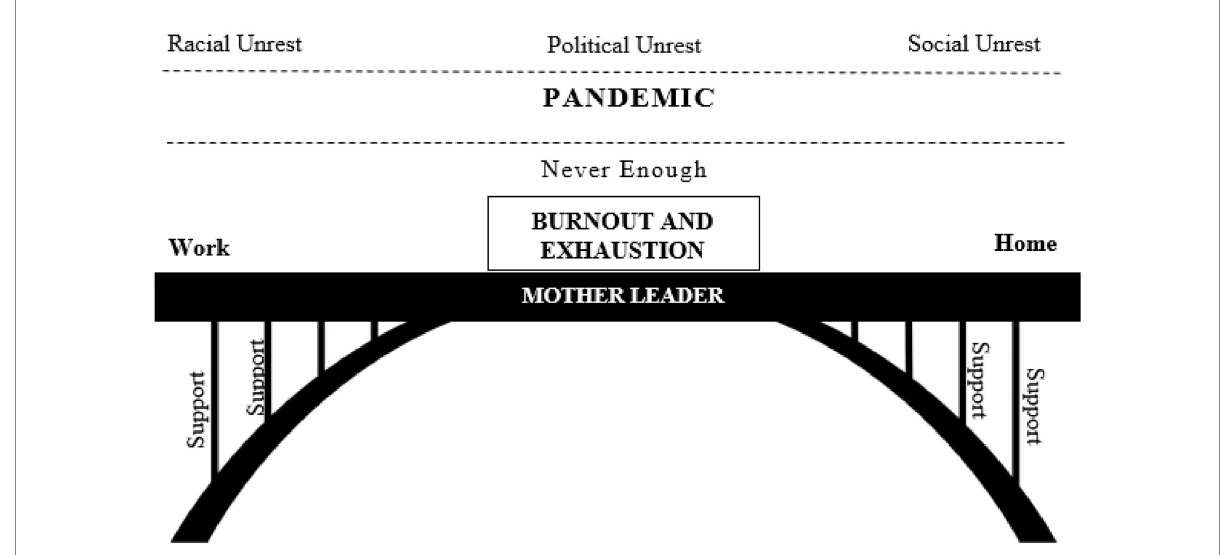
FIGURE 1 The lived experience of mother executive administrators in higher education during